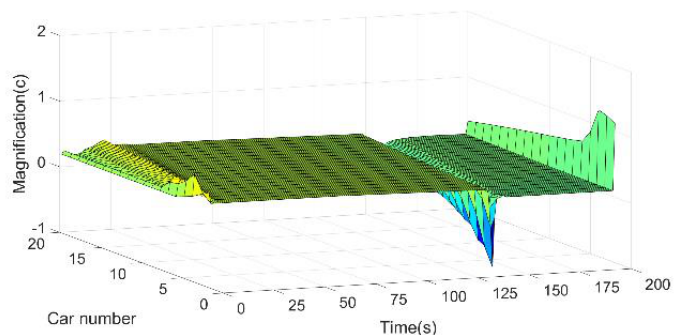
Figure 8. Vehicle current in driving situation 2.